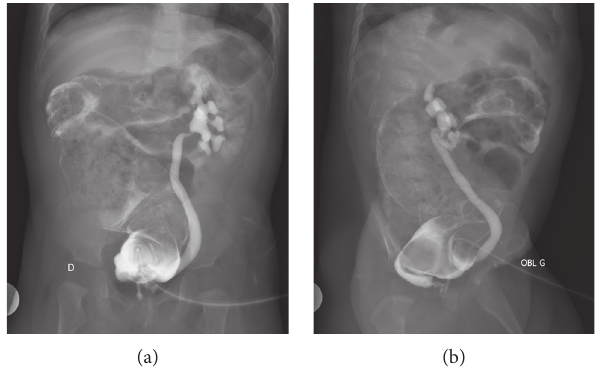
Figure 3: Grade 3 unilateral vesicoureteral reflux (VUR) with a thin tract opening in the